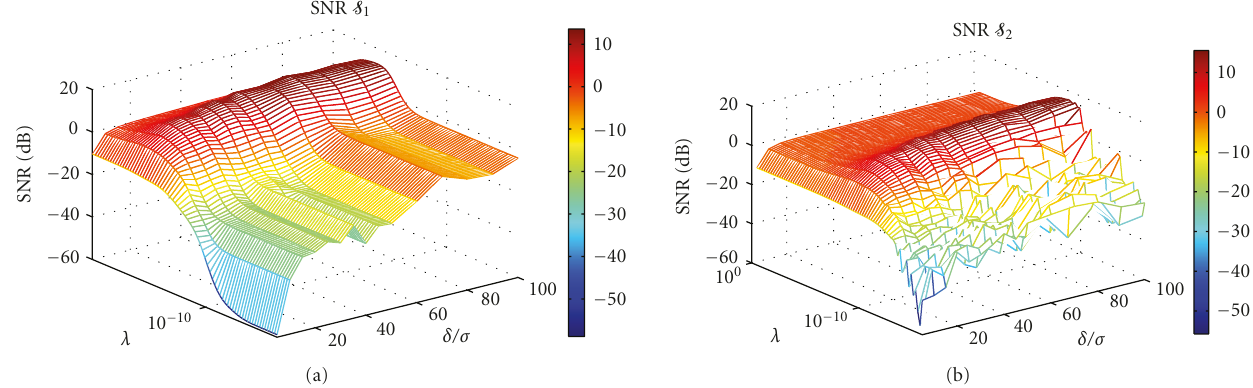
Figure 5: Signal-to-Noise Ratio for di ff erent noise threshold levels and di ff erent values of the smoothing parameter λ . The x -axis represents the threshold-to-noise ratio δ/σ . (a) SNR for recovery in S 1 . (b) SNR for recovery in S 2 .